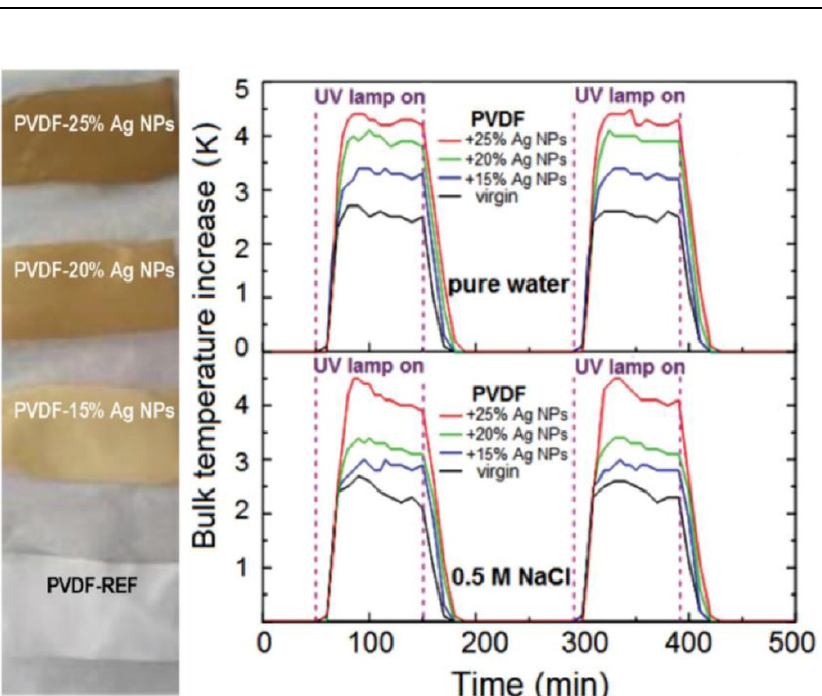
Figure 6. Membranes with different Ag NP loading amounts ( left ) and the effect of Ag NP concentration on the bulk temperature ( right ). Reprinted with permission from Ref. [21]. Copyright 2021 Elsevier. Table 4. Examples of plasmonic membranes from the literature. Modified from [43]. Reproduced with permission from Ref. [43]. Copyright 2022 Royal Society of Chemistry.